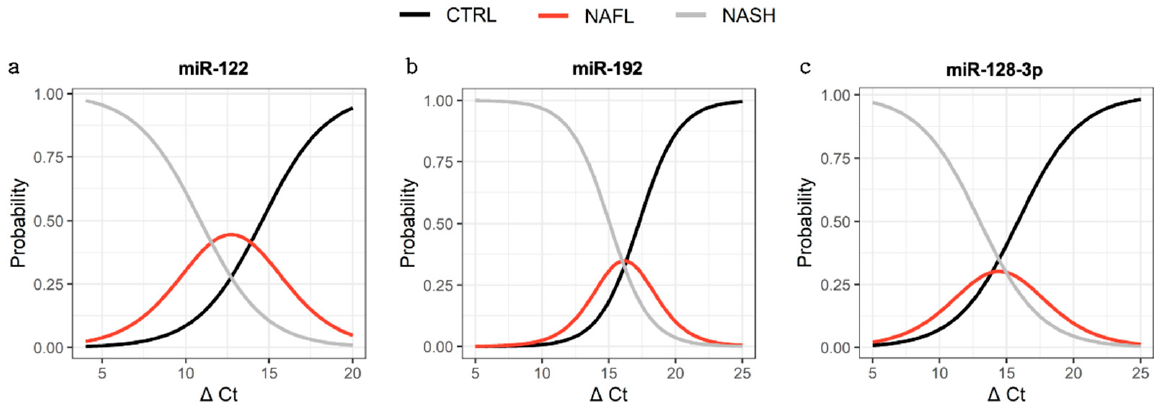
Figure 5. Ordinal logistic regression models. Ordinal regression applied to distinguish control, NAFL and NASH subjects using ASGR1+ EV-derived miR-122 ( a ), miR-192 ( b ), and miR-128-3p ( c ).